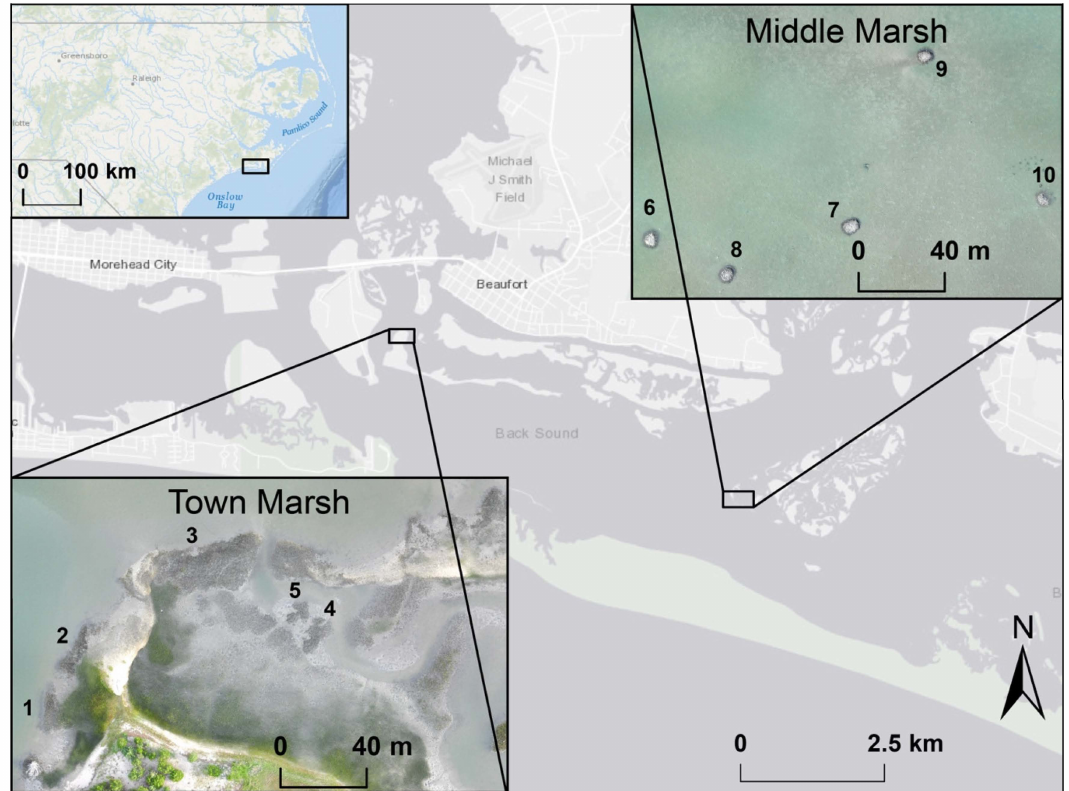
Figure 2. Study area of Town Marsh and Middle Marsh located within the Rachel Carson Reserve, part of the North Carolina National Estuarine Research Reserve (NCNERR, Beaufort, N.C.). Insets include fringing intertidal oyster reefs at Town Marsh and restored intertidal patch reefs at Middle Marsh taken from the senseFly eBee